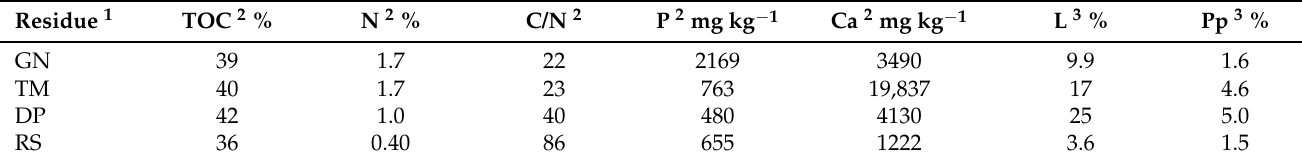
Table 1. Chemical properties of organic residues used in this